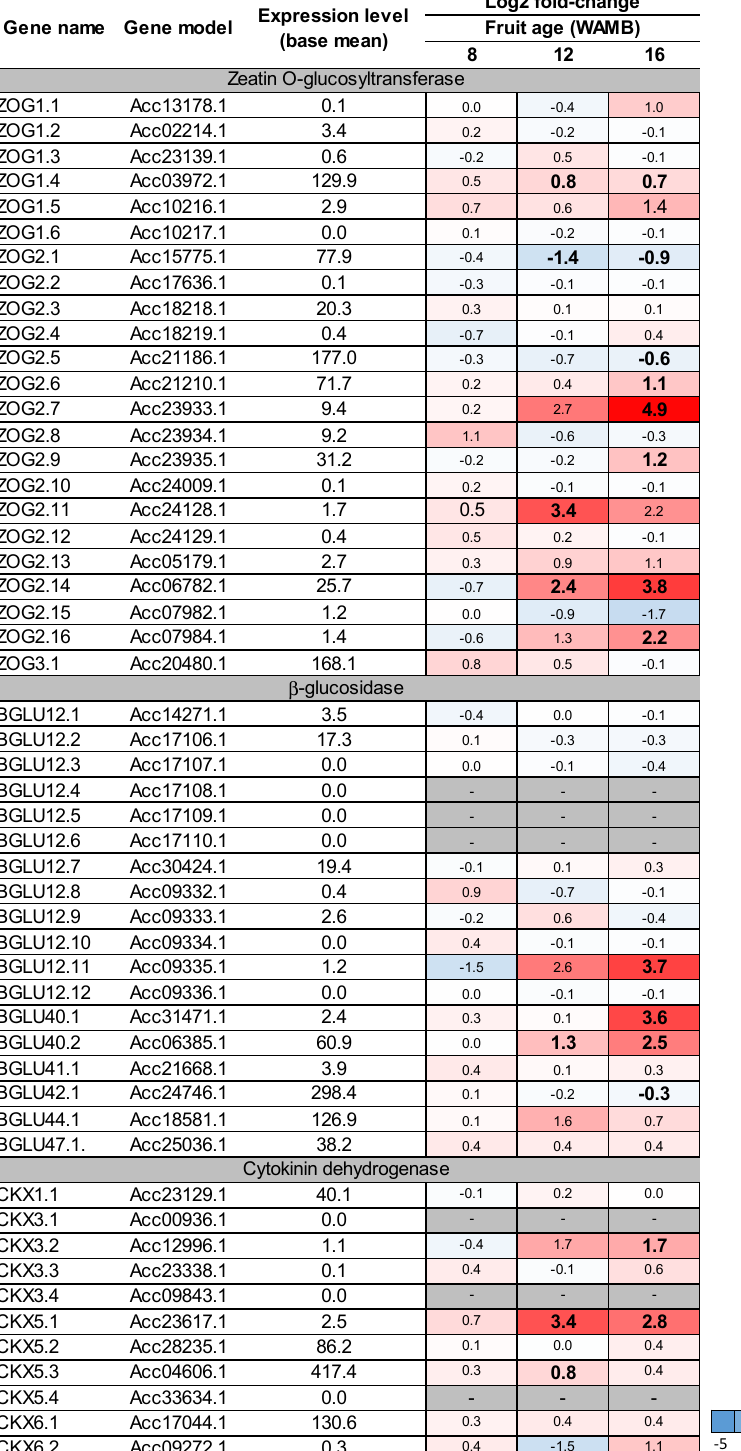
Figure 7. Heat-map of kiwifruit cytokinin catabolic genes. DESeq comparison of low carbohydrate supply (carbon starvation) versus high carbohydrate supply treatments. Differentially expressed genes were identified based on the DESeq analysis from Nardozza et al. [6]. For each gene, the expression level (base mean) and the log2 fold-change are presented. Fruit age is in weeks after mid bloom (WAMB). Bold figures mean differences are significant for adjusted p < 0.05 (DESeq analysis).